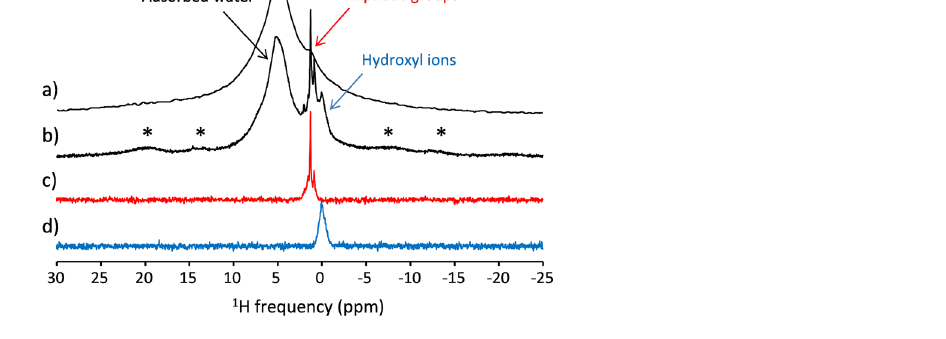
The large increase of the 31 P coherence lifetimes under MAS makes also possible to use larger TE and a selec- tive refocusing pulse of longer duration and narrow bandwidth, as required for 31 P slice-selection imaging. As an illustration, 31 P MAS 2D slice-selection images of the top and bottom parts of the phantom, with slice thicknesses of 710 µ m, are shown in Fig. 2. As for the 3D spin echo experiment, 1 H- 31 P CPMAS was used to reduce experi- mental duration and each 2D image with a spatial resolution of 117 × 155 µ m 2 was obtained in 17 min. It should be noted that the employed spin-echo MAS sequence with slice-selection along the MAS axis involves a frequency encoding step with amplitude-modulated rotating gradients (Fig. 3b). Frequency encoding under MAS with a